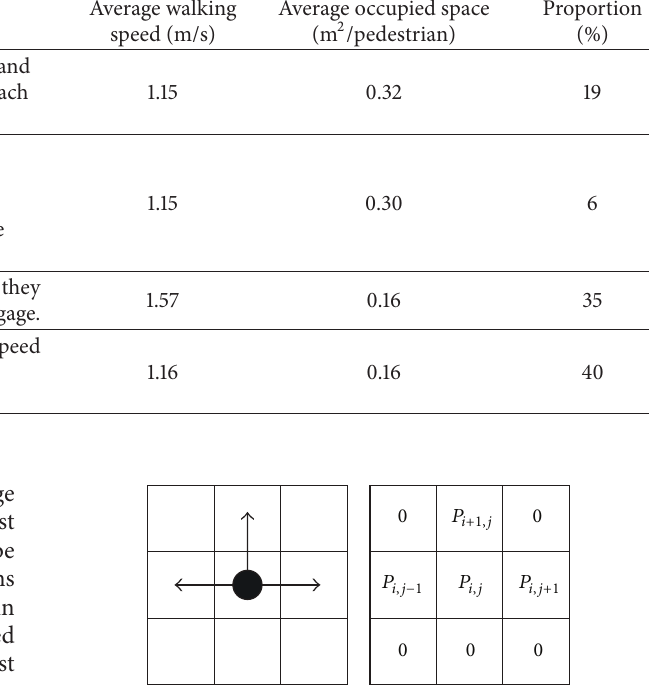
Figure 3: Moving directions and transition probabilities of pedes-